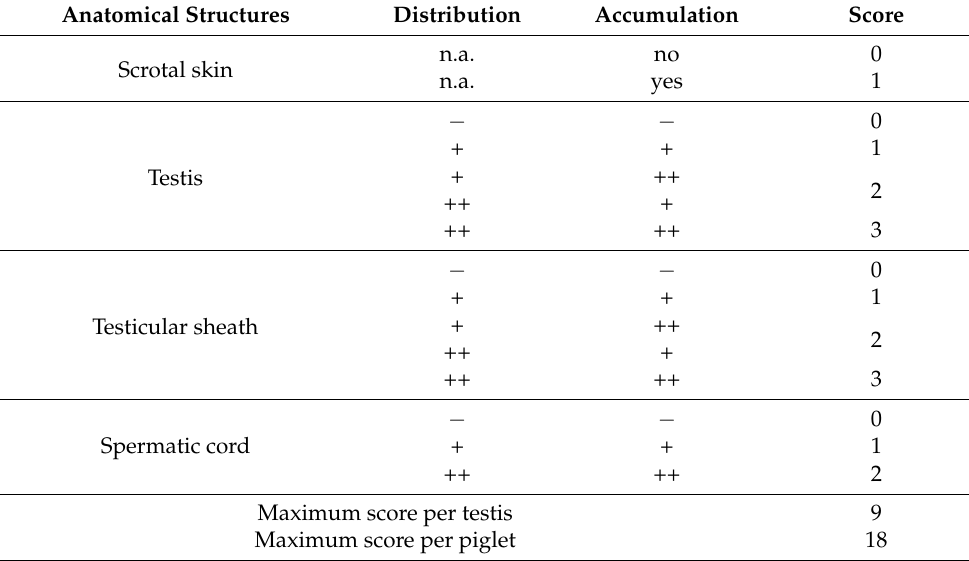
Table 1. CT distribution scoring system.